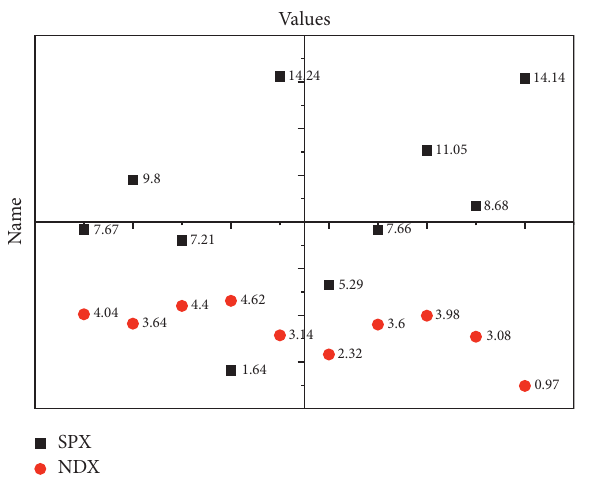
Figure 5: Scatter plot of indices.